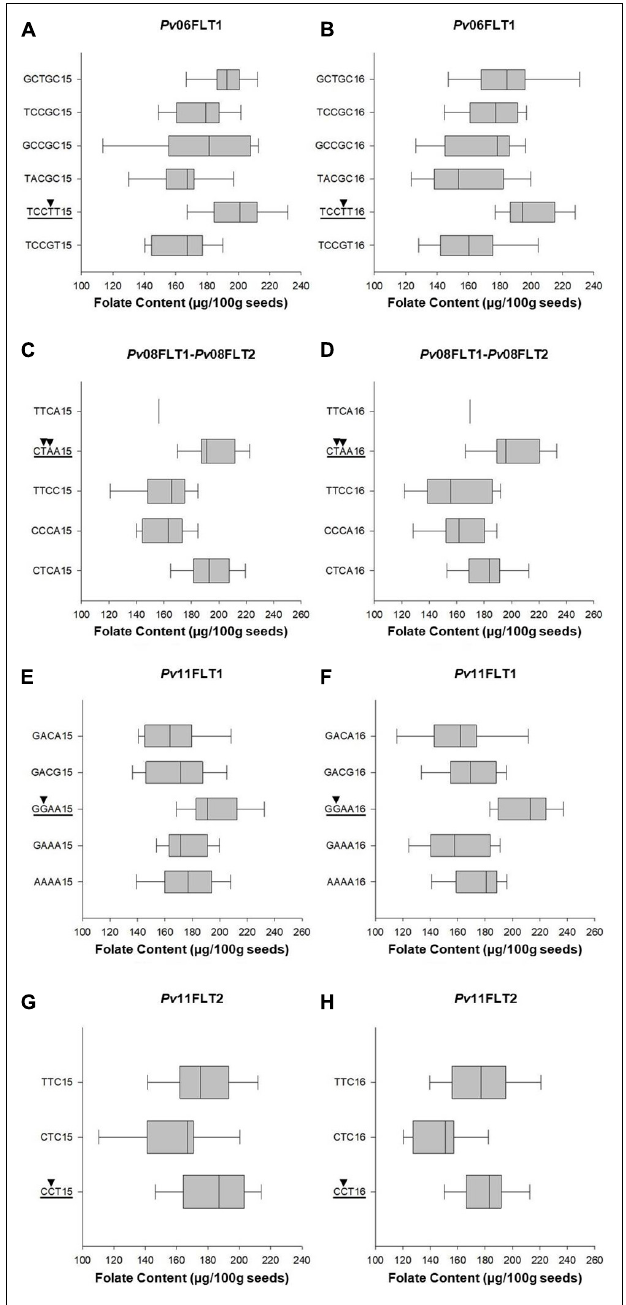
FIGURE 7 | Box plots showing the phenotypic distributions of total seed folate contents for haplotypes based on six QTL identified by GWAS with the FarmCPU model. The QTL names are indicated above each panel (A–H) . The haplotypes containing the QTL allele with the highest average seed folate content are underlined, and the SNP alleles are identified by black arrowheads. Each haplotype is followed by either 15 or 16, which corresponds to the 2015 and 2016 experiments,